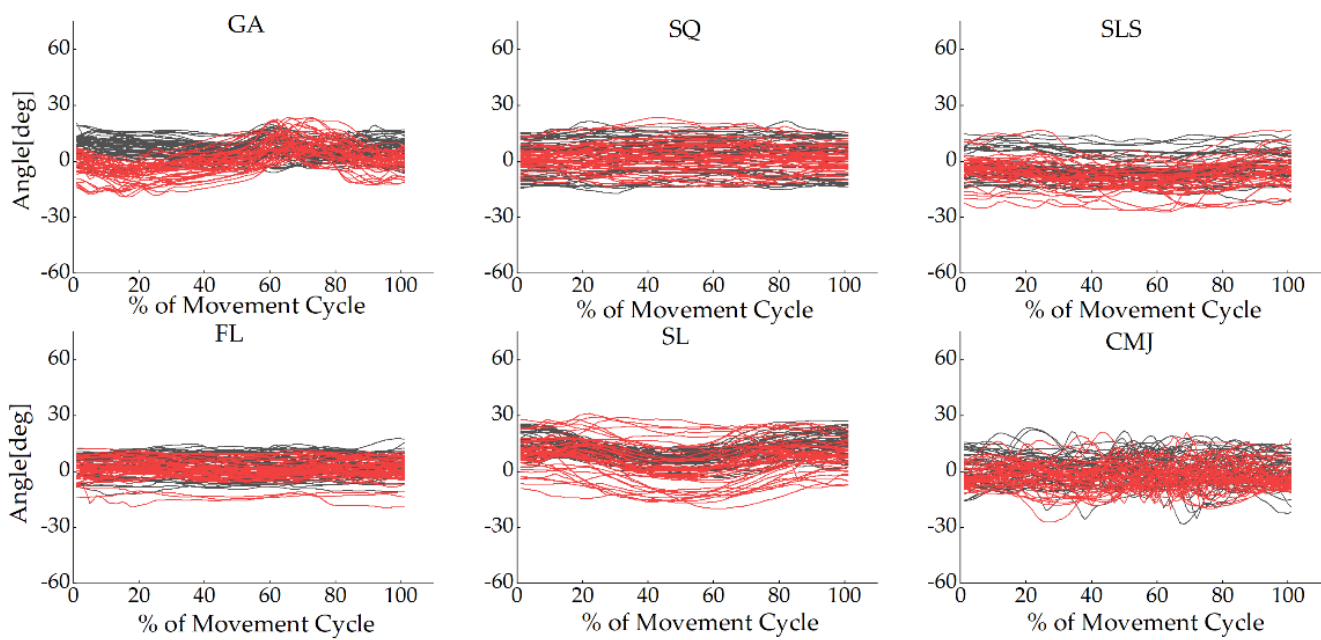
Figure A5. Ankle joint angles in the frontal plane for each participant in all tasks during the movement cycle of the gait (GA), squat (SQ), single-leg squat (SLS), side lunge (SL), forward lunge (FL), and counter-movement jump (CMJ). The black lines represent the OptiTrack system, while the red lines represent the Perception Neuron ® system. The Y -axis depicts joint angles in degrees, while the X -axis depicts the movement cycle in %.